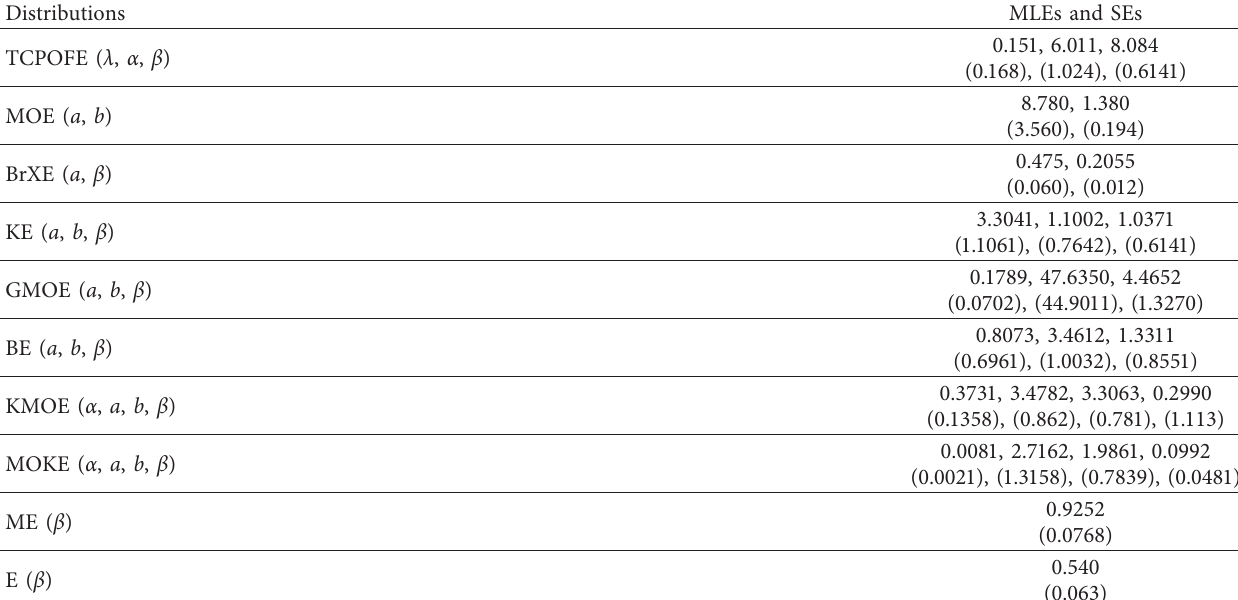
Table 2: Estimates for dataset I.